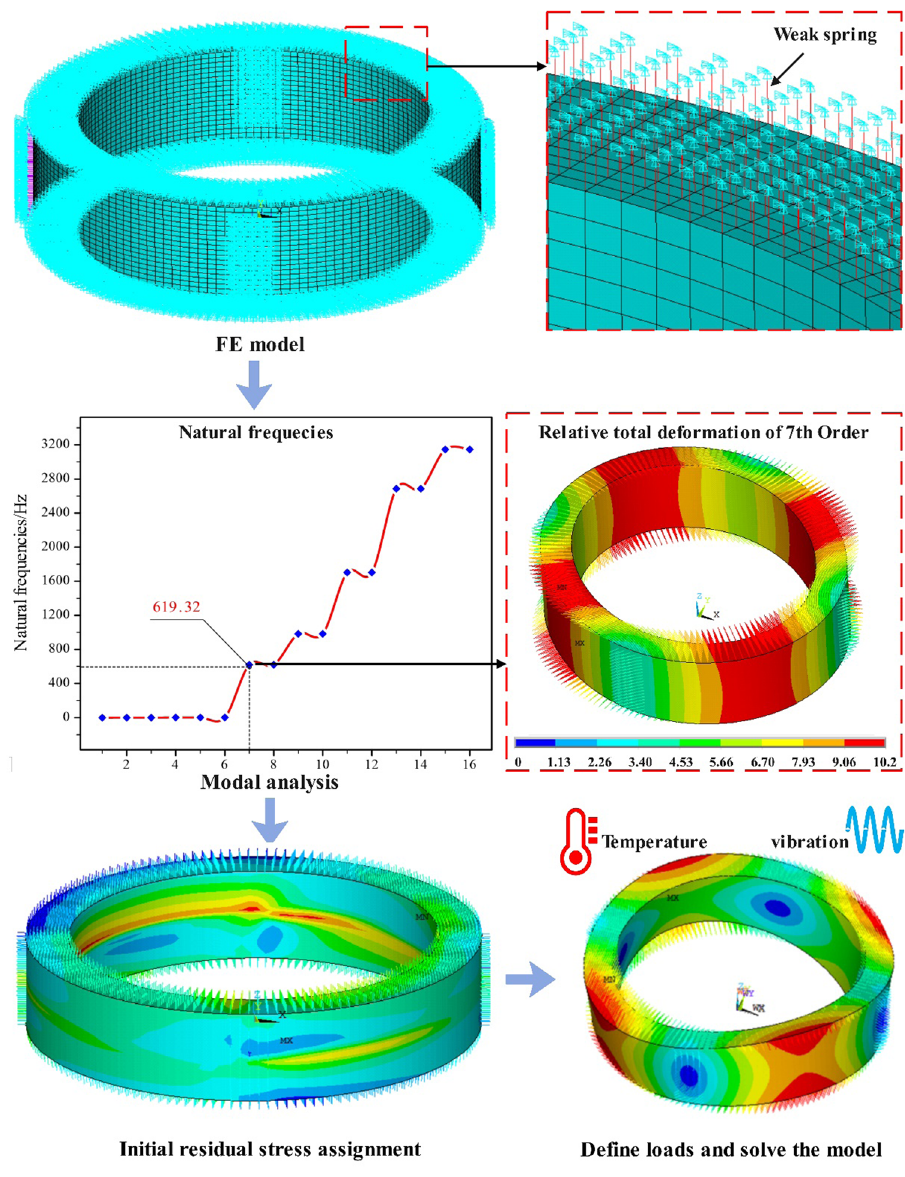
Figure 2: General modeling and analysis fl ow of